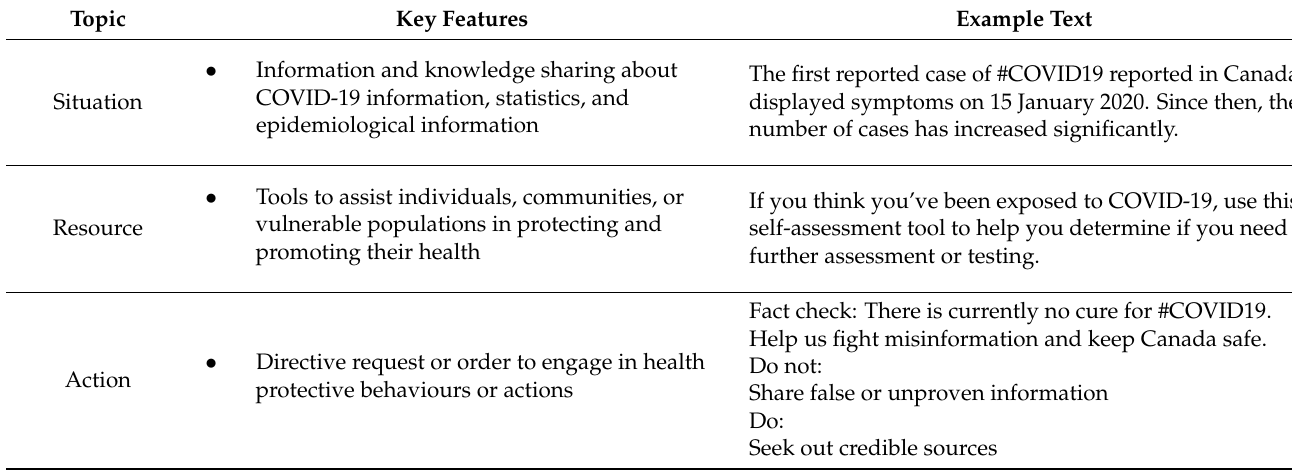
Table 2. Key features of crisis communication